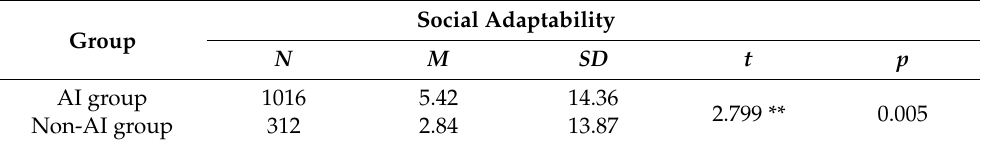
Figure 2. Social adaptability differences between AI group and non-AI group predicted by PDP. Table 3. Results of differences in social adaptability between AI group and non-AI group. Table 4. Social adaptability of AI group and non-AI group.